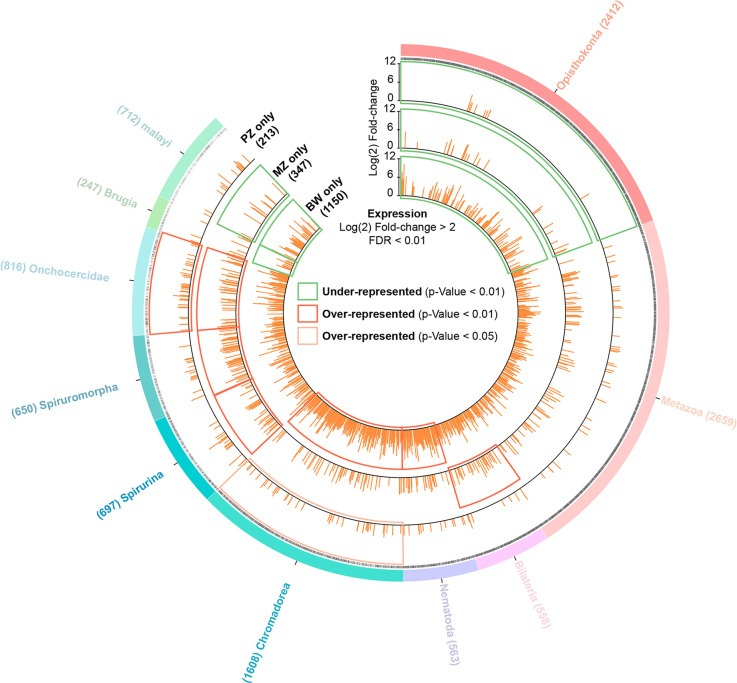
Distribution of B. malayi expressed genes at the taxonomic level.Circos plot representing 10,922 B. malayi genes with their level of fold change of expression. Circles from outermost radius to innermost: clade root origin of each B. malayi gene; presence or absence of GO functional annotation (black: presence; gray: absence); gene expression levels (orange bars) with a log2(fold change) > 2 and a FDR < 0.01 are considered specific for PZ (versus MZ+BW); MZ (vs PZ+BW); and for BW (vs PZ +MZ). Green squares highlight taxonomy levels that are under-represented in genes with a Fisher’s exact test p-value < 0.01; red squares highlight taxonomy levels over-represented in genes (Fisher’s exact test p-value < 0.01); and orange squares highlight taxonomy levels that are over-represented in genes with a Fisher’s exact test p-value < 0.05.